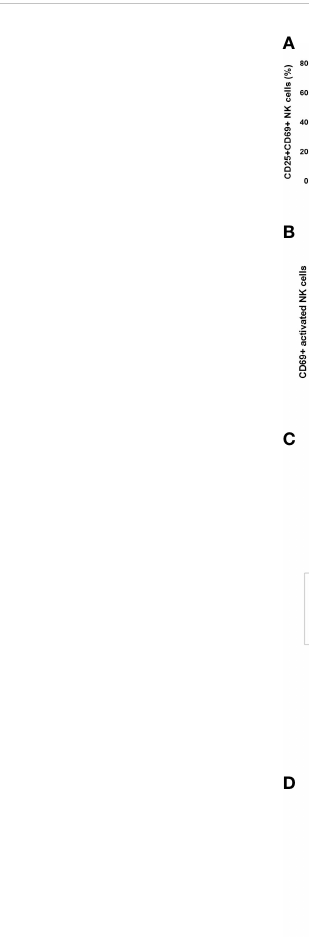
FIGURE 6 Depth of NK cell activation does not correlate with their cytotoxic activity. (A) Abundance of CD25+CD69+ NK cells (left) or CD16 expression (MFI) on NK cells (right) after 16-20h incubation in ADCC assay with Target cells (Pfeiffer, EOL-1 or AML22) treated with CD25 Mab or isotype control antibody. (B-D) Data obtained at ADCC assay endpoint (20h). Experimental procedure is described in the Figure 5E. (B) Abundance of CD69+ NK cells represented as count per µl in the absence or presence of target cells and test molecules. Bar graph represents mean +/- SEM for each NK cell donor with technical duplicates. Two-way ANOVA, Tukey ’ s multiple comparison test. (C) Heatmap of selected cytokine concentrations (mean values in pg/mL) detected in the supernatant by Luminex analysis. Row and column dendrograms represent hierarchical clustering using UPGMA method and Euclidean distance. (D) Log2 fold change of cytokine concentration obtained with CD25 Mab treatment as compared to isotype control antibody for seven differentially expressed cytokines. Each pictograph represents the mean of technical duplicates for each NK cell donor. Signi fi cance levels are de fi ned in the methods section. P values > 0.05 are not indicated on the graphs. NK: Natural Killer cell; ADCC: Antibody dependent cellular cytotoxicity. Signi fi cance levels are indicated as follows: ns or not indicated, not signi fi cant, P > 0.05; *P ≤ 0.05; **P ≤ 0.01; ***P ≤ 0.001; ****P ≤